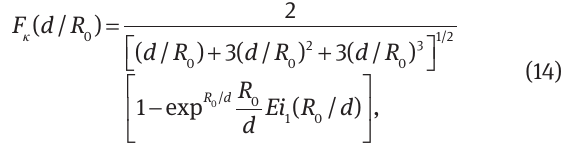
Figure 1: Explanation of Wannier exciton localization on the metal nanosphere of radius R (A) Plot of | Φ ( R , θ ) | 2 – the probability density of the exciton center of mass. Also shown is a the excitonic radius. (B) Three-dimensional representation of center of mass probability density around metal